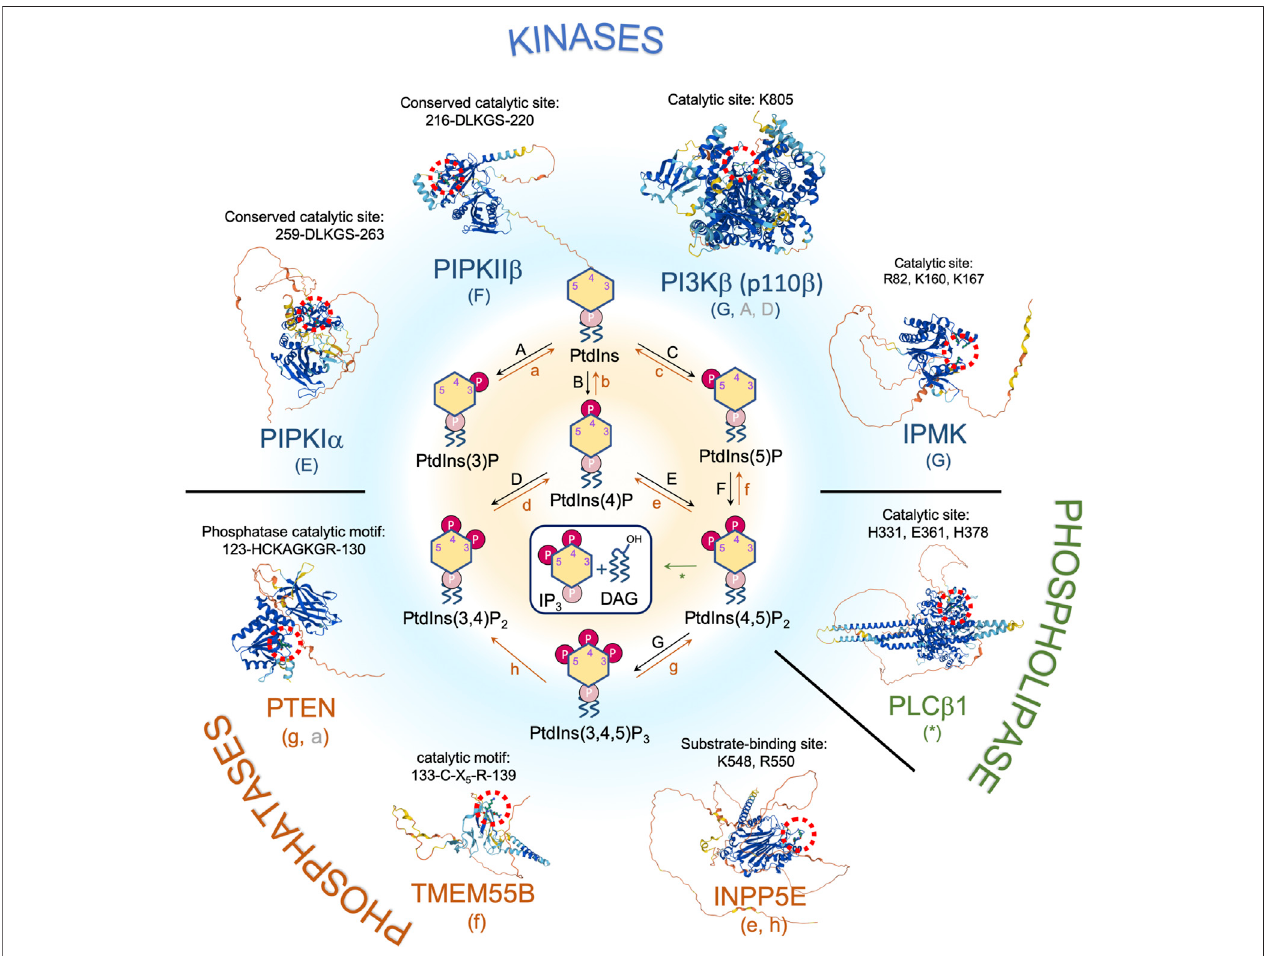
FIGURE 1 | Nuclear phosphoinositide metabolism and involved enzymes with implications in DNA damage response and/or tumor suppression. Representative proteins/isoforms are shown as full length structures predicted by AlphaFold. Studies indicate that PIPKI α , PIPKII β , and PTEN might exist as dimers. Whether dimerizationisrequired fortheirkinase activities and in response toDNAdamage requires furtherinvestigation (Heinrichet al.,2015;Huet al., 2015;Droubiet al.,2016). Red dotted circle labels the catalytic site of each protein. The letters in the parentheses under each enzyme correspond to the pathways indicated in the center panel. Letters in gray represent a minor pathway. Note that PI(3,5)P 2 is not detected in nucleus.